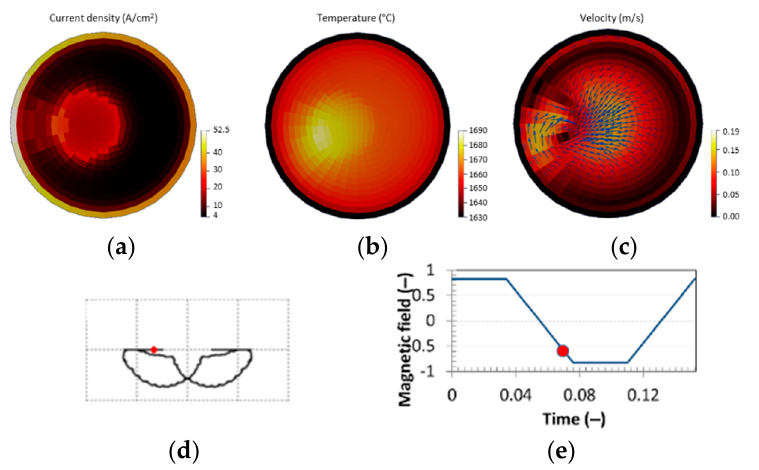
Figure 9. Distributions of ( a ) the current density, ( b ) metal temperature and ( c ) liquid metal velocity in the mesh layer adjacent to the ingot top surface during a ramp of the stirring sequence. ( d ) Orientation of the arc pattern and actual location of the arc centroid. ( e ) Actual time instant along the stirring sequence.